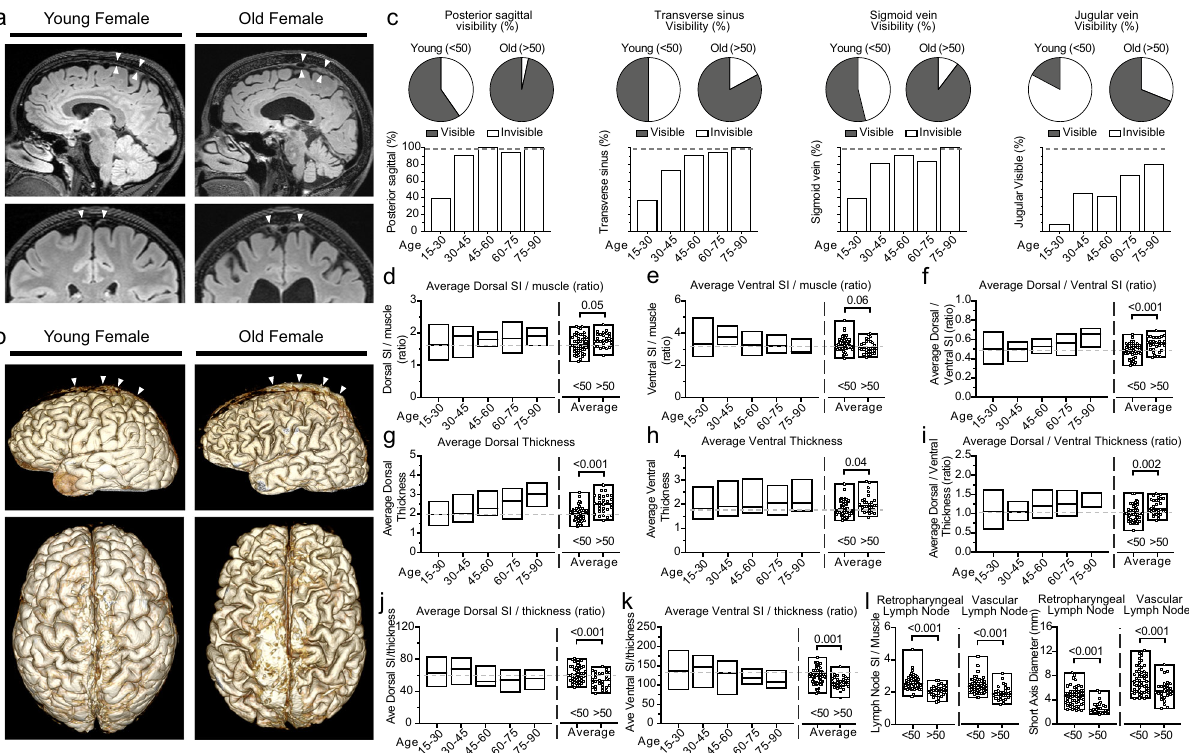
Fig. 6 Age effects on dorsal and ventral dural lymphatic structures. a Dorsal parasagittal dural lymphatic system in young and aged female subjects. Sagittal FLAIR images and coronal magni fi ed FLAIR images reveal a signi fi cant increase in thickness and extension of the parasagittal dural lymphatics structures along the sagittal sinus (arrowheads) in the aged subject. b Comparisons of the 3D representation of dorsal parasagittal dural lymphatics as de fi ned from T2-FLAIR. Images depict the brain for the lateral (upper image) and dorsal (lower image) views. c Comparison of visibility of dorsal lymphatics between older and younger age groups and across decades of age. d – k Comparison of thickness and signal intensity values of dorsal and ventral lymphatic systems between older and younger age groups and across the age groups. Student t test was used to compare older and younger age groups. All tests are two-sided. l Comparisons of retropharyngeal and vascular lymph node SI and short diameter by age groups. Student t test was used to compare older and younger age groups. All tests are two-sided. Data are presented as mean values ± SEM. [Age: 15 – 30; N = 35], [Age: 30 – 45; N =